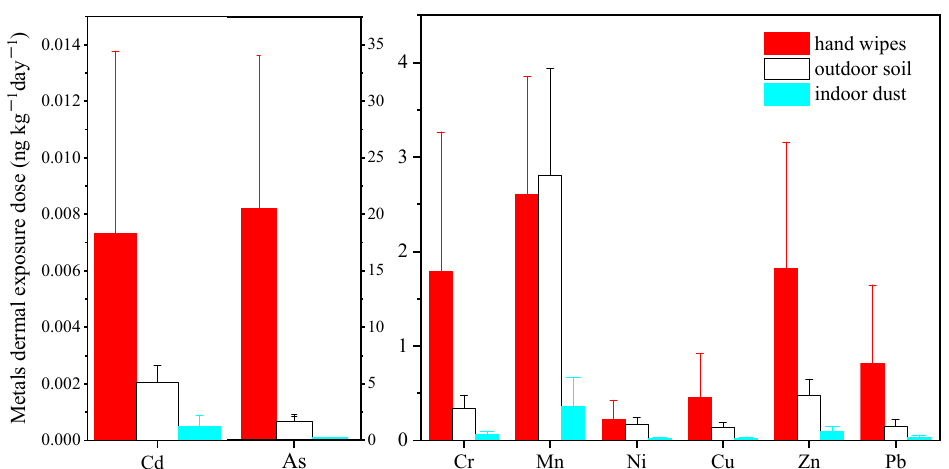
Figure 3. Comparison of metal hand-dermal exposure dose via hand wipe, outdoor soil and indoor dust.